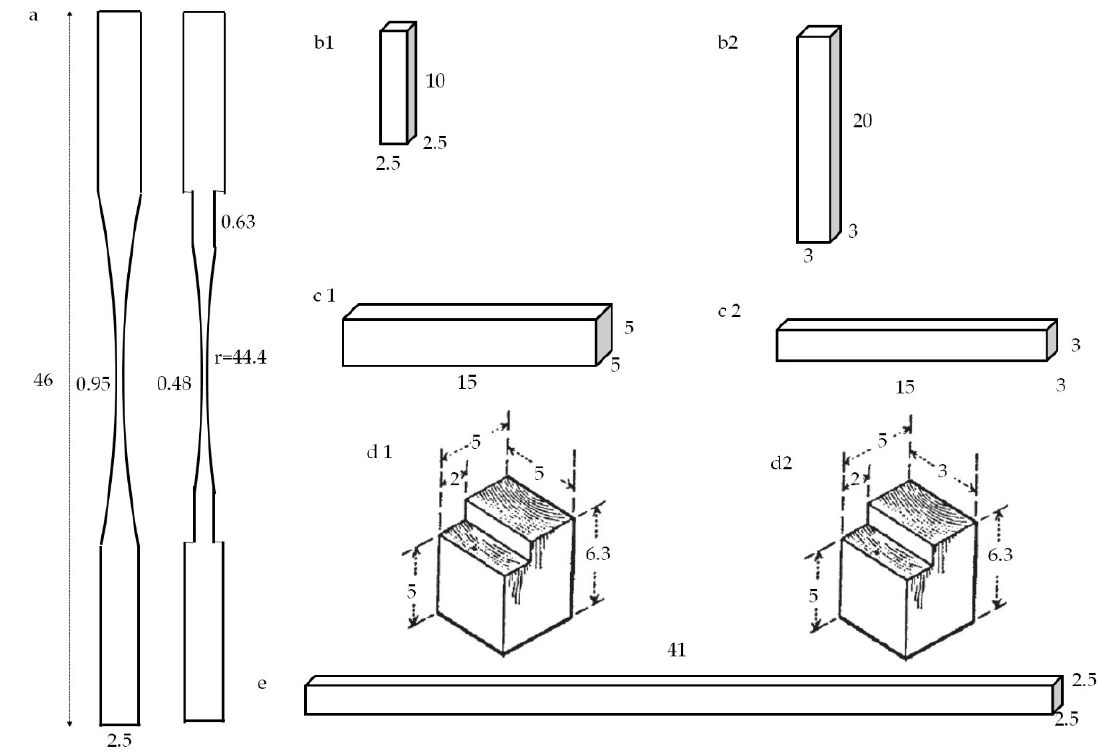
Figure 1. Timber and scrimber specimens for tensile test parallel-to-fiber ( a ), timber ( b1 ) and scrimber ( b2 ) specimens for compressive test parallel-to-fiber, timber ( c1 ) and scrimber ( c2 ) specimens for compressive test perpendicular to fiber, timber ( d1 ) and scrimber ( d2 ) specimens for shear test, timber and scrimber specimens for bending test ( e ). (Note: the size unit is cm)